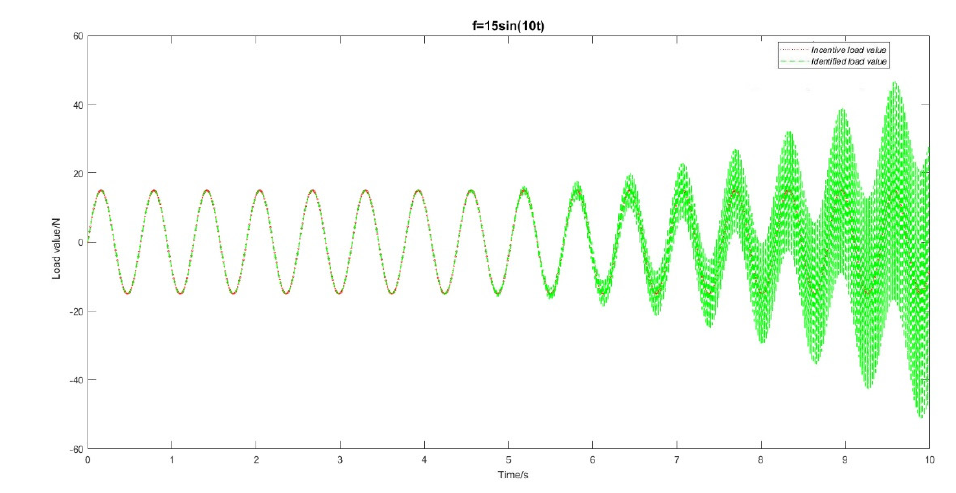
Figure 6. Load identification error comparison with Newmark method.